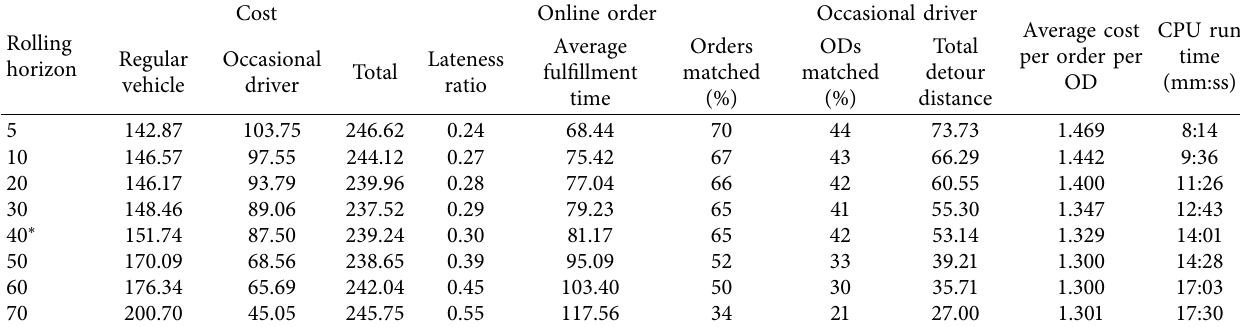
Table 2: Base case under different rolling horizons.